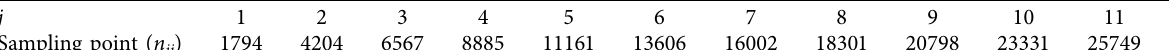
Figure 15: Engine abnormal noise signal of the first cylinder lacking. Table 5: The sampling point corresponding to the fault feature points of each period.